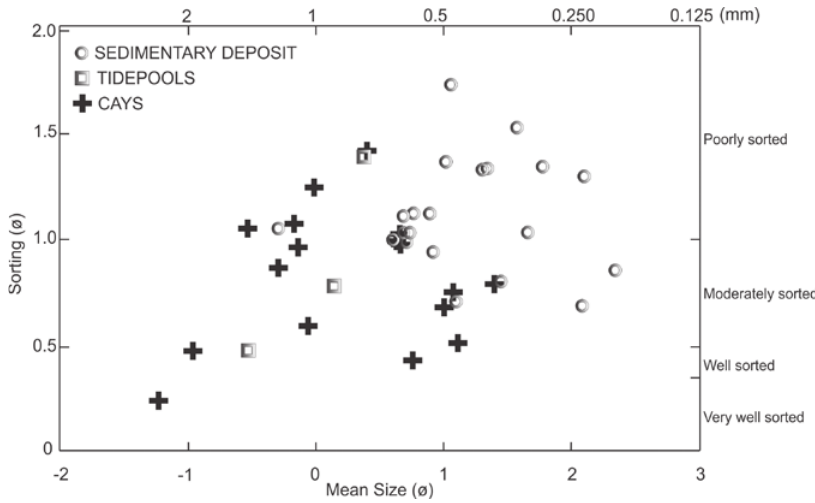
Figure 10 - Plotting of mean grain size and sorting values of samples from sedimentary deposit , tidepools and cays of Rocas